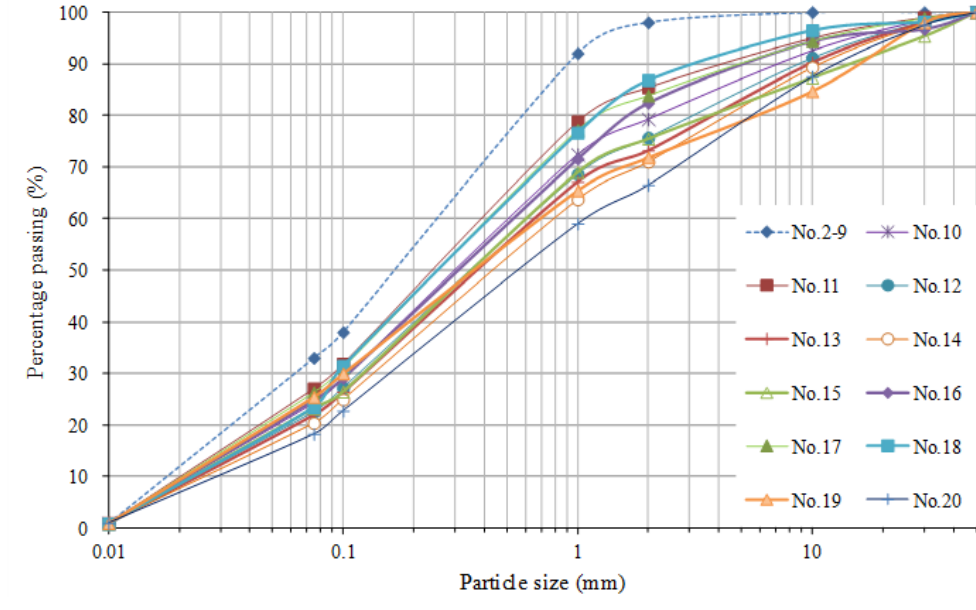
Figure 5. The particle size distribution of 20 experimental tests.